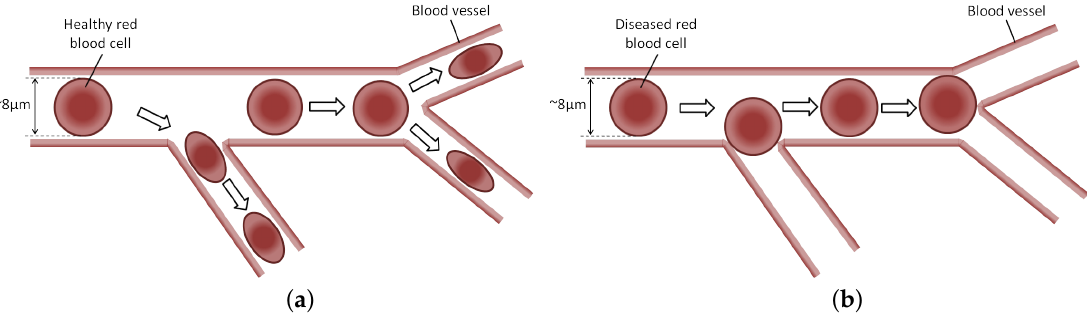
Figure 1. Schematic illustration of red blood cells (RBCs) flowing within a blood vessel. Healthy RBCs can freely flow through the smaller blood vessels due to their ability to undergo cellular deformation ( a ).